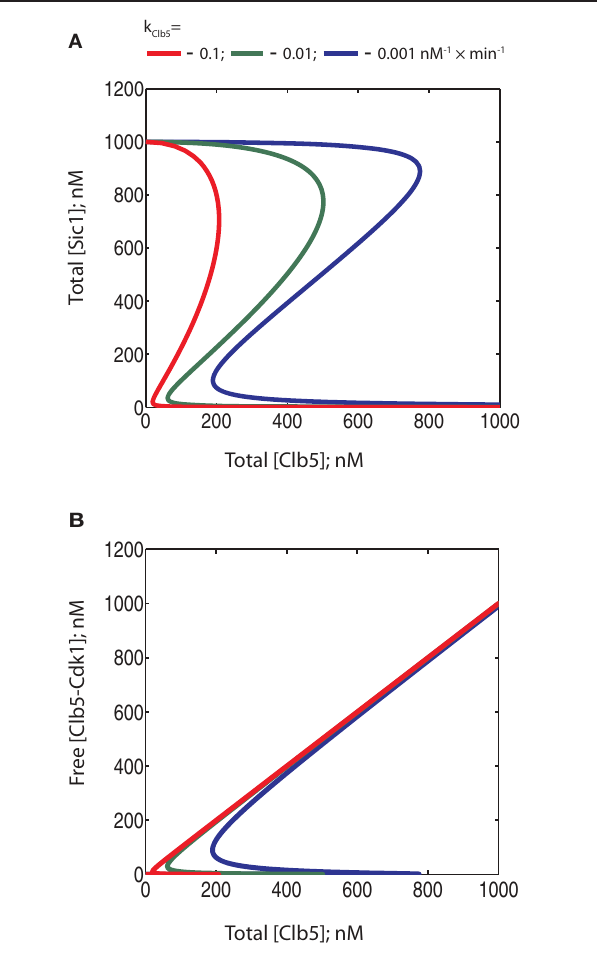
FIGURE 7 | Phase diagrams showing the potential effect of Cln2-dependent priming phosphorylation on the bistability of the system. The rate constant value of 0.001nM × min − 1 for Clb5-Cdk1 exemplifies a system with no Cln2-dependent priming while increasing values of this constant mimic increased levels of Cln2-dependent priming effect. (A) Phase diagrams showing the dependence of free Clb5-Cdk1 activity on total Clb5-Cdk1 levels. (B) Phase diagrams showing the dependence of total Sic1 concentration on total Clb5-Cdk1. The color coding is the same for both